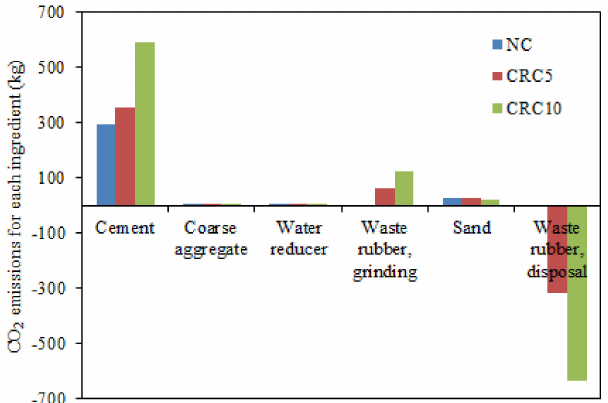
Figure 8. CO 2 emission for each ingredient in concrete.